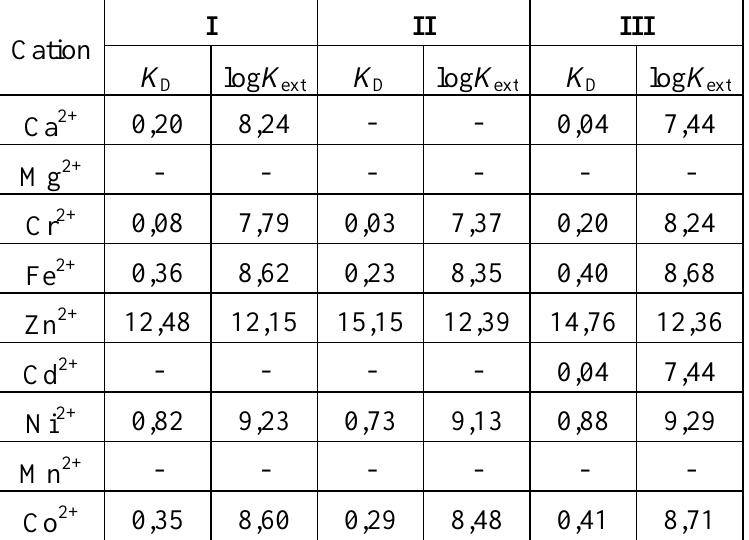
Table 2. Equilibrium constants for extractions of Ca 2+ , Mg 2+ , Cr 2+ , Fe 2+ , Zn 2+ , Cd 2+ , Ni 2+ , Mn 2+ , Co 2+ with chiral Schiff bases in CH